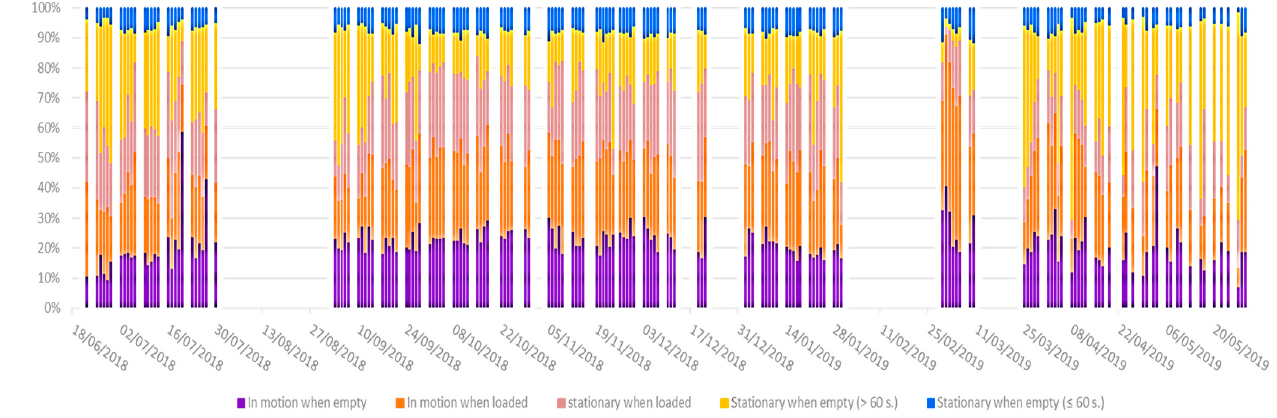
Figure 9. Utilization of the tower crane over time.